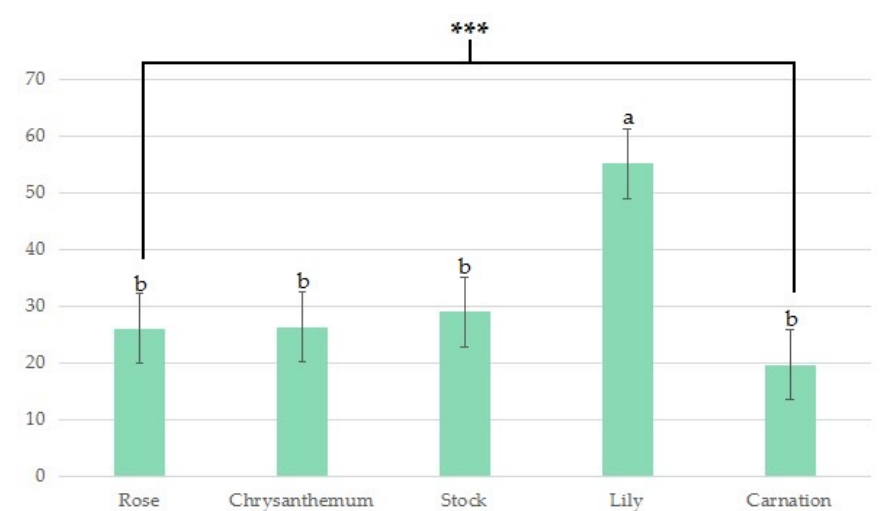
Figure 7. Scent strength of five different types of flowers; no sensation (0 score), weak (1–5 score), moderate (6–15 score), strong (16–35 score), very strong (36–50 score), and strongest imaginable (51–100 score) (*** is p <0.001, a > b).